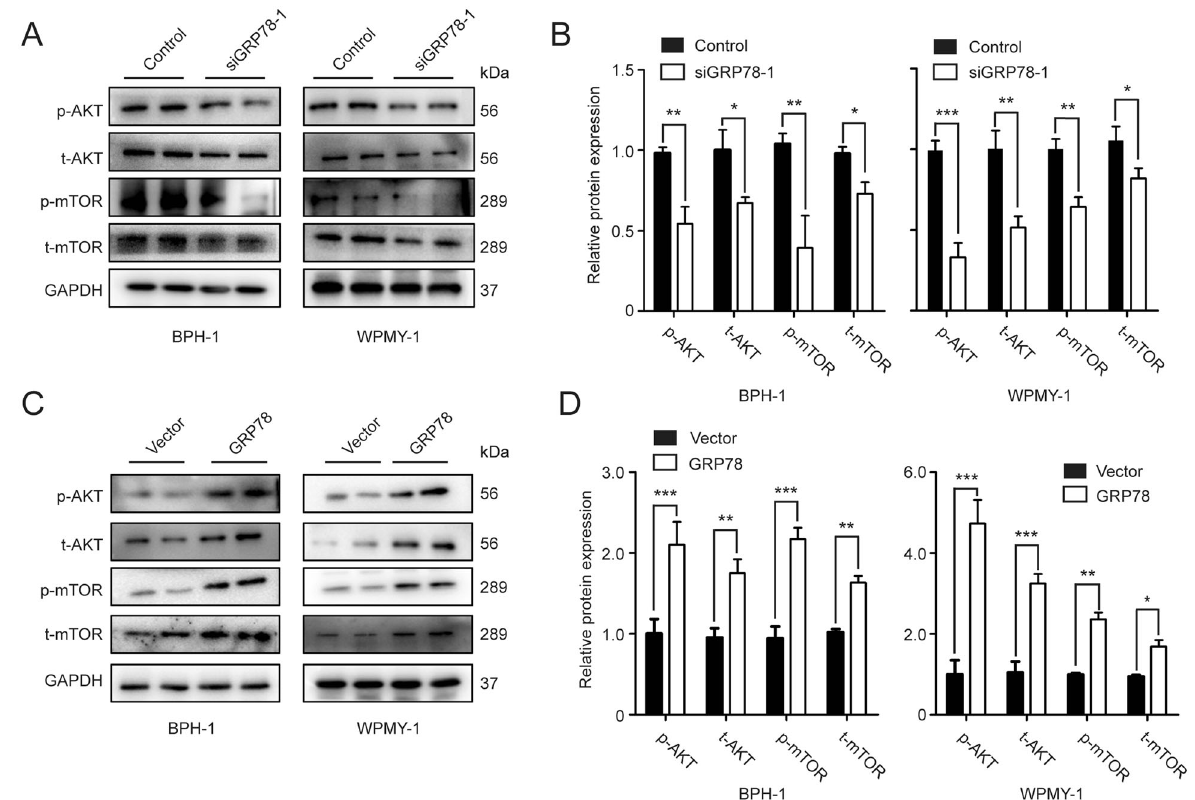
Fig. 4 GRP78 modulates apoptosis-related AKT/mTOR signaling in prostate cells. A , B Immunoblot assay and relative densitometric quanti fi cation of four molecular markers for AKT signal pathway, t-AKT, p-AKT, t-mTOR and p-mTOR, in GRP78-silenced prostate cells. C , D Immunoblot assay and relative densitometric quanti fi cation of four molecular markers for AKT signal pathway in GRP78-overexpressed cells. GAPDH is used as loading control. * p < 0.05; ** p < 0.01; *** p <